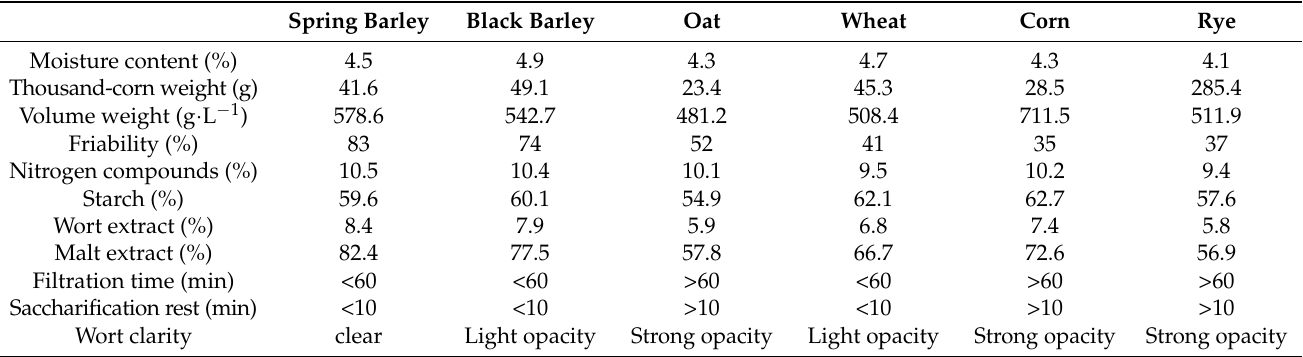
Table 2. Characteristics of measured